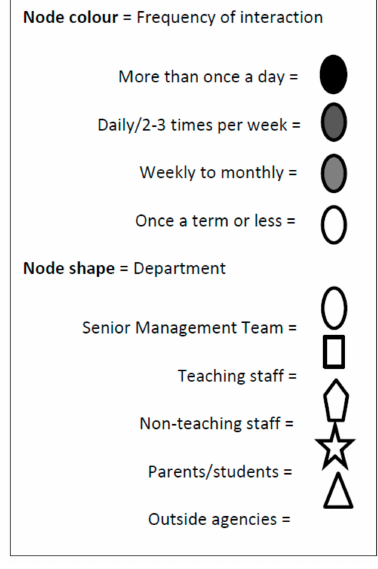
Figure 1. Key for net-map diagrams.